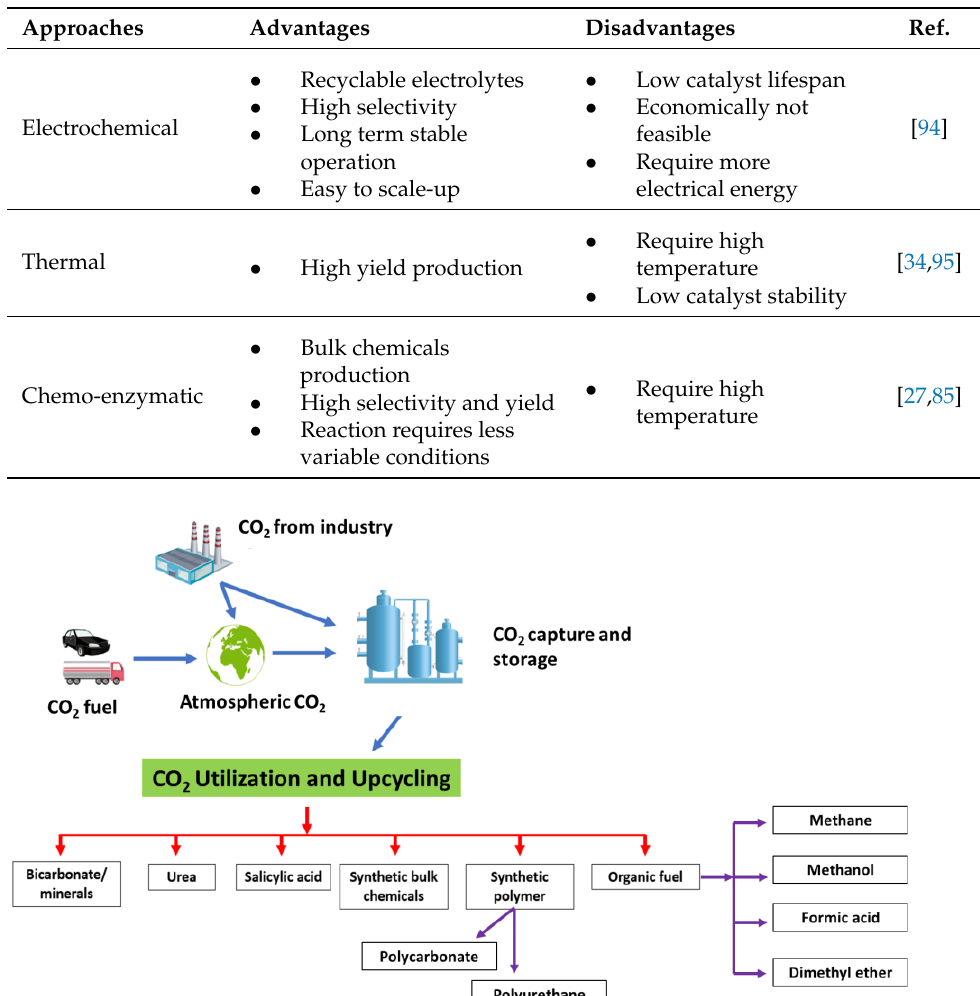
Table 3. Advantages and disadvantages of various CO 2 conversion approaches.